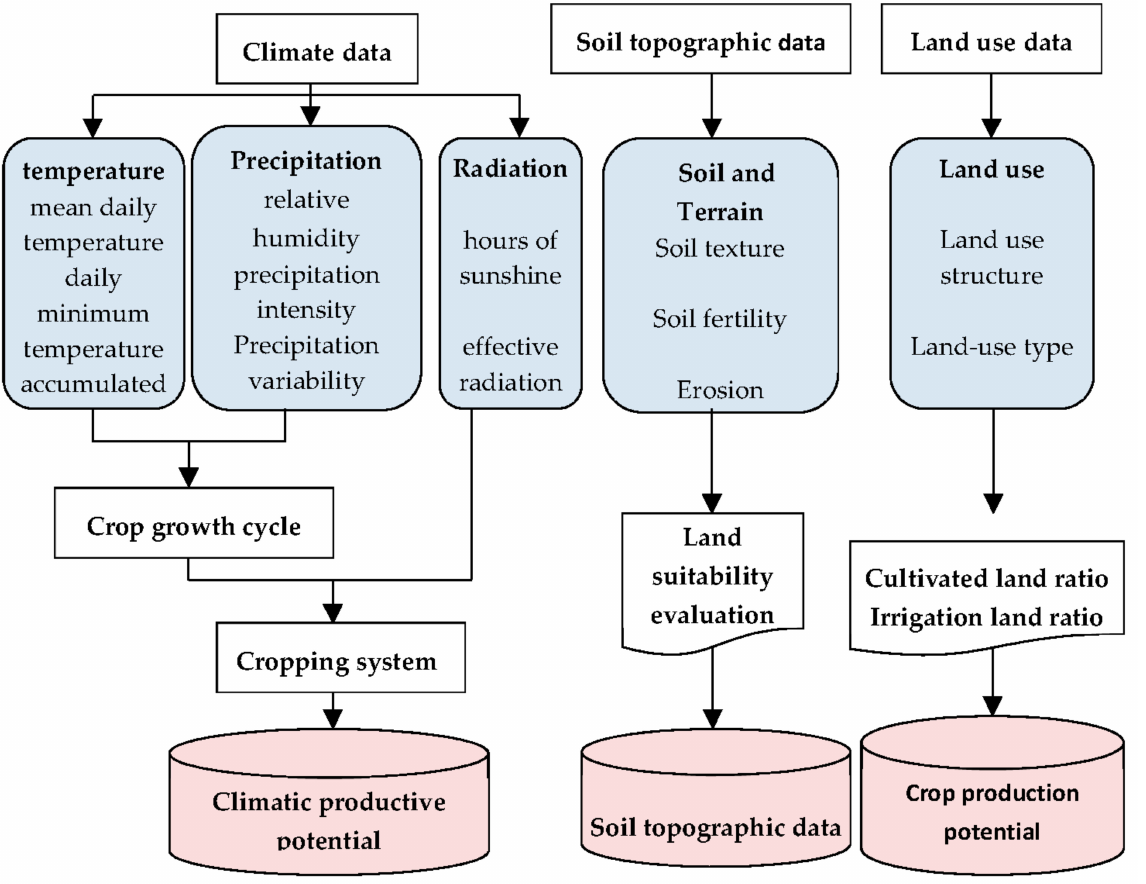
Figure 2. GAEZ model